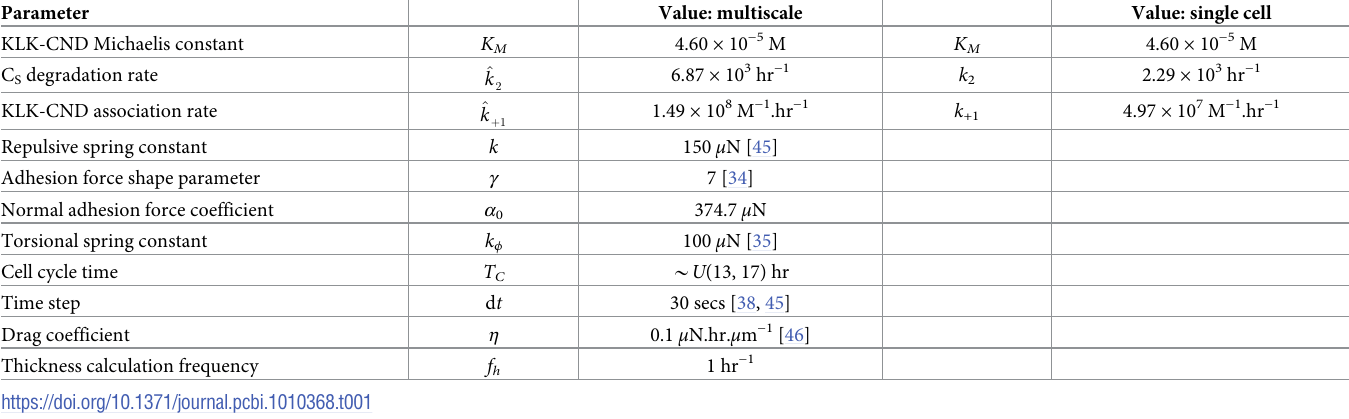
Table 1. The parameter values for the subcellular and multiscale model. Values are given for the multiscale model and the rate parameters used for the single cell system are given in columns 3 and 5